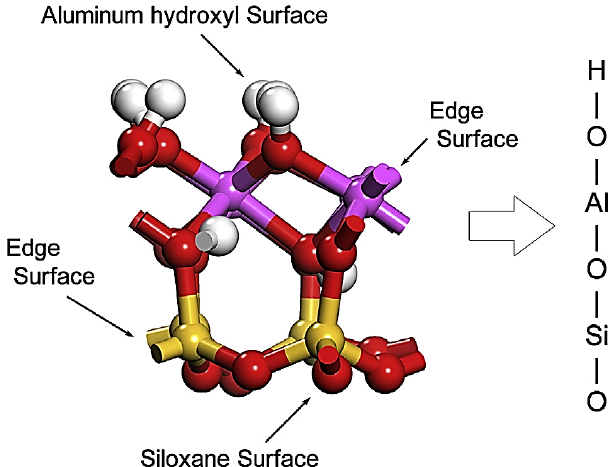
Figure 1. Structure of kaolinite primitive cell (white, hydrogen; red oxygen; pink, aluminum; yellow, silicon) [19].